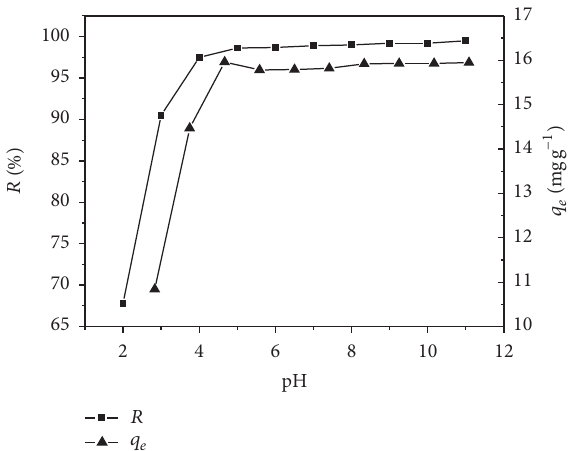
Figure 3: Effect of initial pH on MB adsorption (conditions: tempe- rature (298 K), dye concentration (20 mg/L), particle size (80mesh), adsorbent dosage (1.25g/L), and contact time